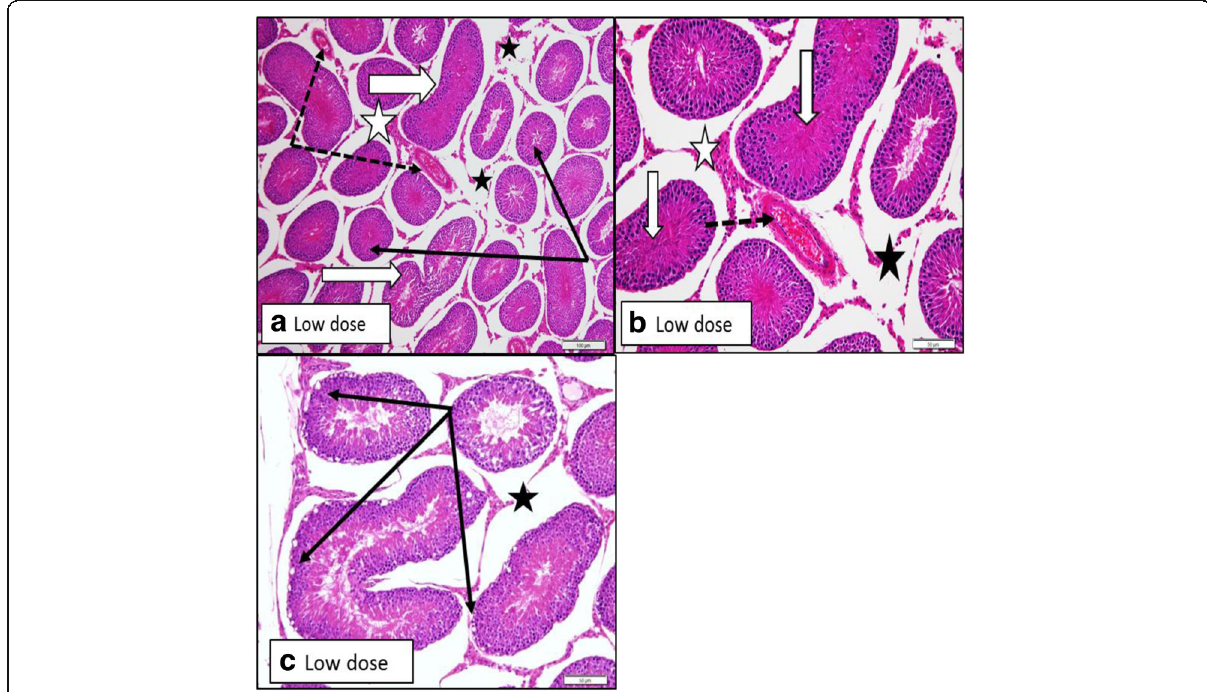
Fig. 6 Sections from the rat testis administered with low-dose hair dye for 8 days show the following: a deformity (white arrows) and shrinkage (thin black arrows) of seminiferous tubules. Interstitial spaces were increased (stars) with compensatory hyperplasia of Lyedig cells (white star) (H-E, ×200). b Higher magnification show deformed tubule with homogenous material within the lumen masking the few number of mature sperms (white arrows), increase or hyperplasia of Lyedig cells (white star), and increase of tissue spaces due to atrophy of tubules (black star) (notice the blood vessel with thick wall) (dotted arrow) (H-E, ×200). c Some samples showed basal vacuoles between germ cells (black arrows). Tissue spaces are also widen (black stars) with hyperplasia of Leydig cells (H-E,